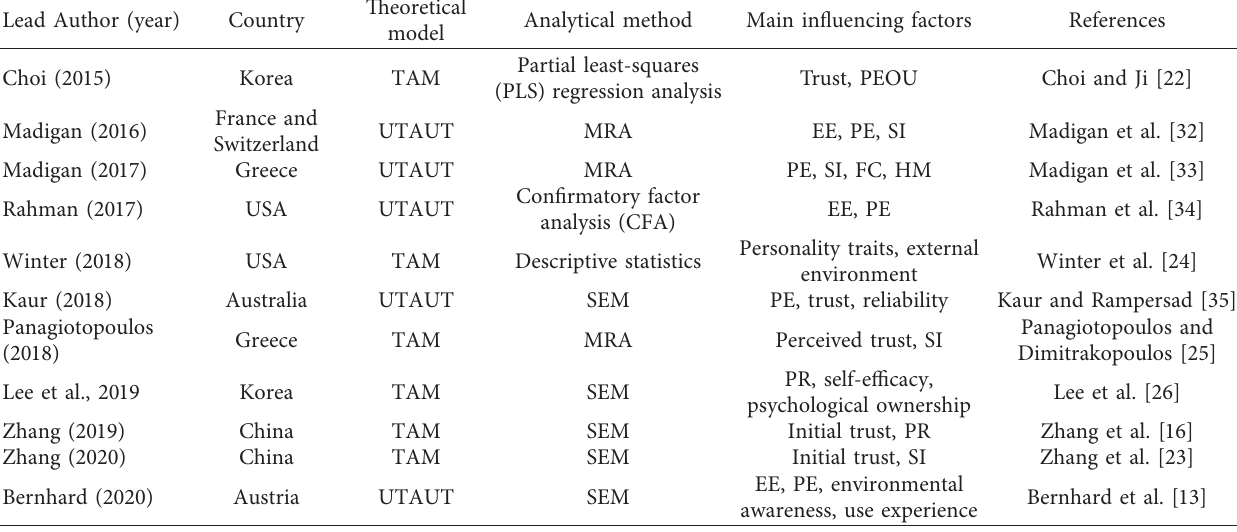
Table 1: Research exploring the public acceptance of autonomous driving technology using the TAM or UTAUT model.